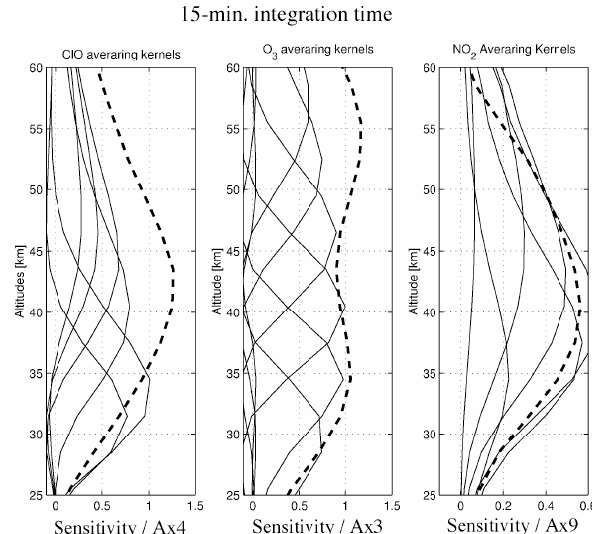
Fig. 7. Averaging kernels calculated from 28 to 58km by a step of 6km (thin line) and measurement sensitivity (thick dash line) for ClO, O 3 and NO 2 , representative of a 15-minute integration